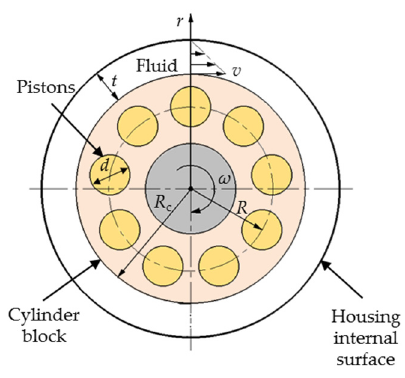
Figure 5. Churning losses due to the cylinder block: geometrical data.